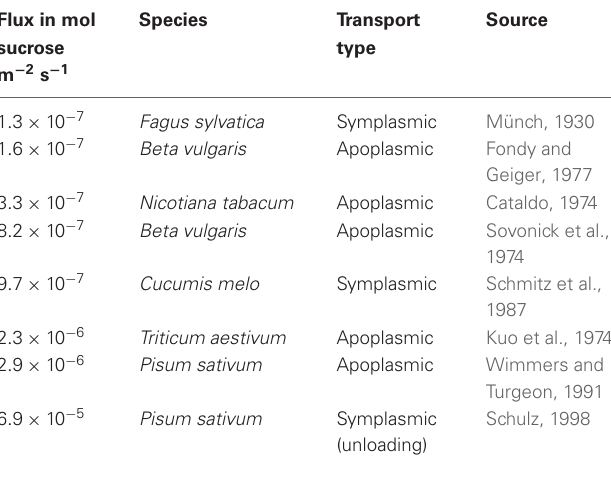
Table 2 | Sucrose flux rates across the bundle sheath-companion cell interface reported in the